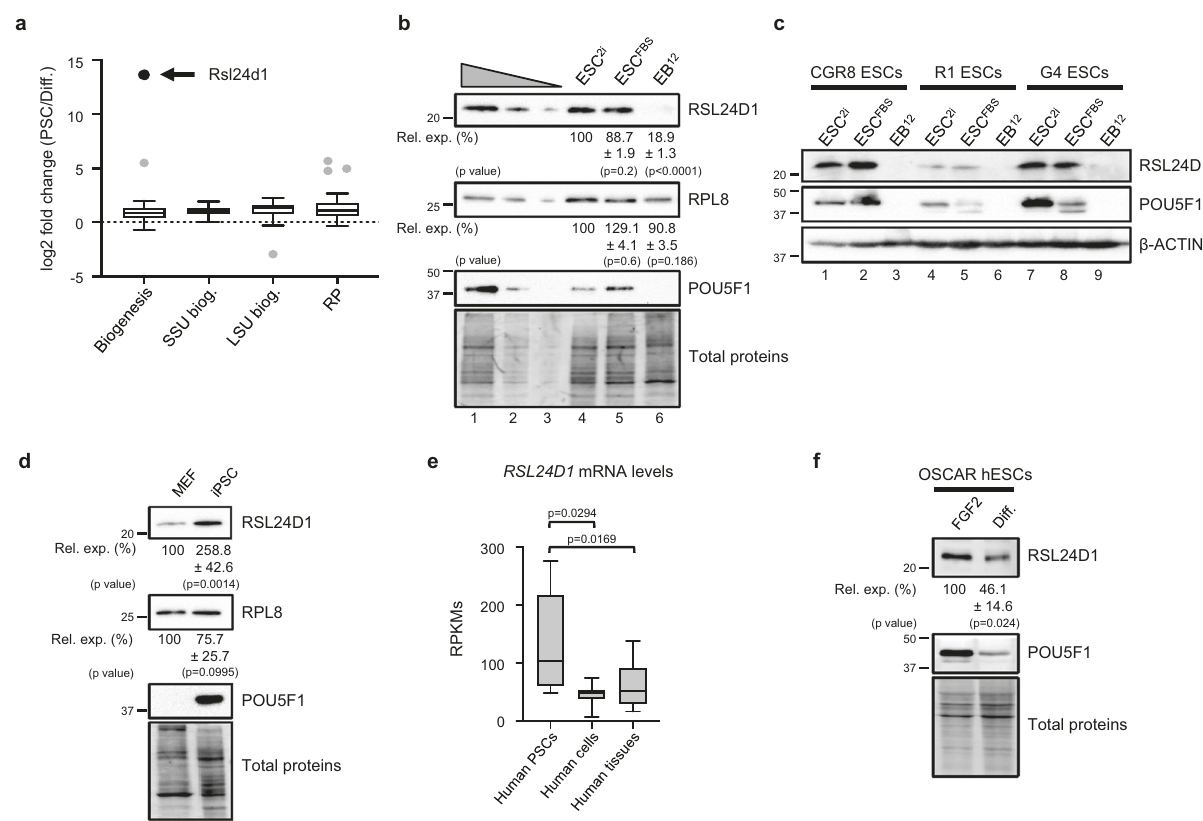
Fig.1|Rsl24d1expressionisenrichedinPSCs.a BoxplotrepresentationofmRNA expression changes in mouse PSCs (5 ESC lines and 2 iPSC clones) and 6 differ- entiatedcelllines,measuredbyRNA-seq,forfactorsinvolvedincommonribosome biogenesis (Biogenesis), speci fi c biogenesis factors of the 40S (SSU biog.) or 60S subunits (LSU biog.), and ribosomal proteins (RP). Outlier values and Rsl24d1 are representedbygrayandblackdots,respectively.Additionaldetailsareprovidedin SupplementalFig.S1aandinSupplementaryData1.Theboxesrepresentthe25thto 75th inter-quartile (IQR) and the whiskers+/ − 1.5 IQR. The median and the outliers are represented by a line and individual dots, respectively. b Representative immunoblots of mouse CGR8 ESCs cultivated in ESC 2i or ESC FBS conditions, or differentiatedasembryoid bodiesfor12days(EB 12 )( n =4).Lanes1to3correspond